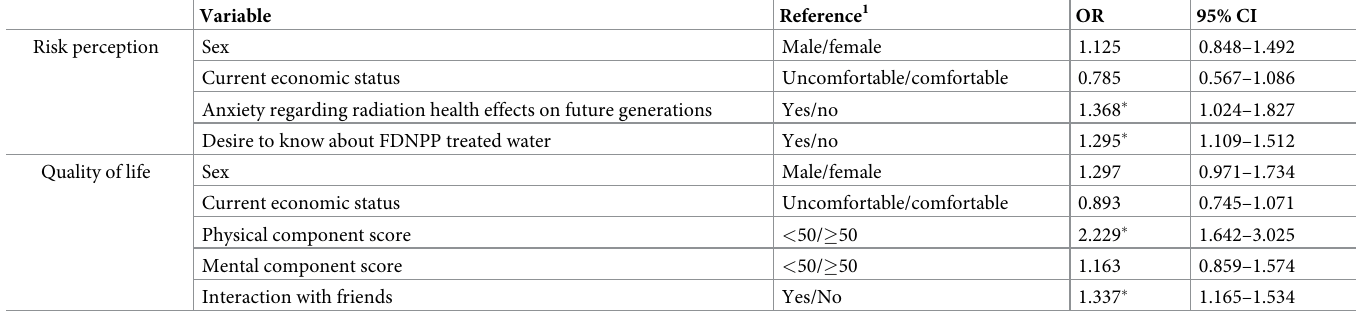
Table 3. Logistic regression–risk perception and quality of life for elderly